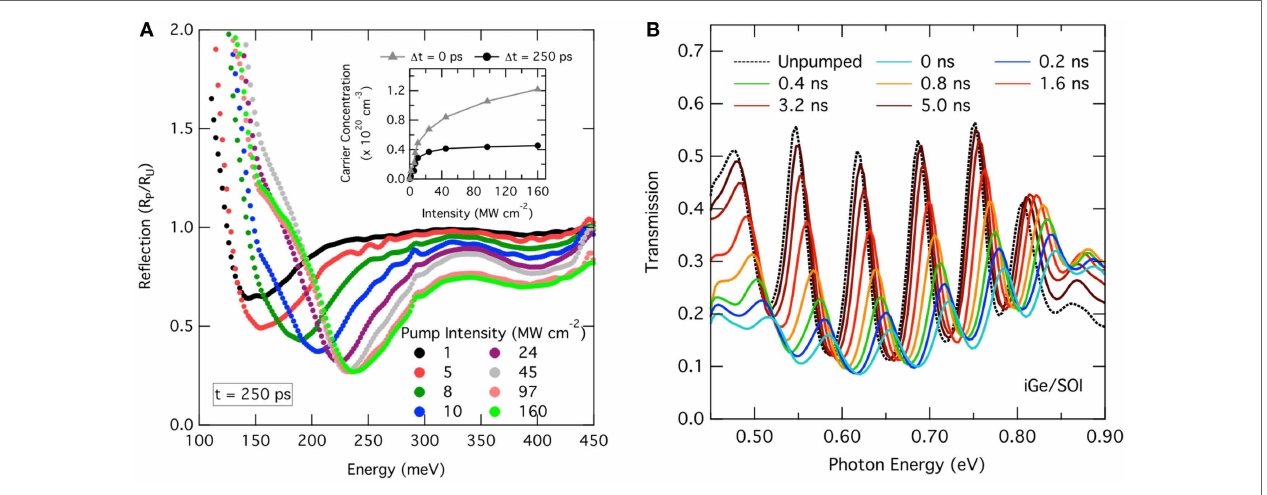
the total amount of charge carriers. The inset shows the carrier concentration for 0 and 250 ps delay time in dependence of the excitation power. (B) Normal- incidence pump–probe transmission spectra for Ge on SOI for varying delay times. Strong Fabry–Perot oscillations are observed from the thin film interference. Analyzing the peak-shifts facilitates the extraction of the decay